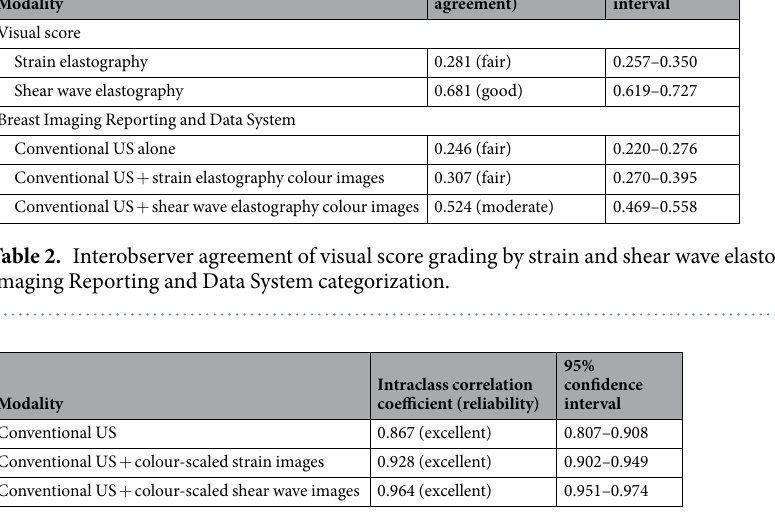
Table 3. Interobserver agreement of cancer probability